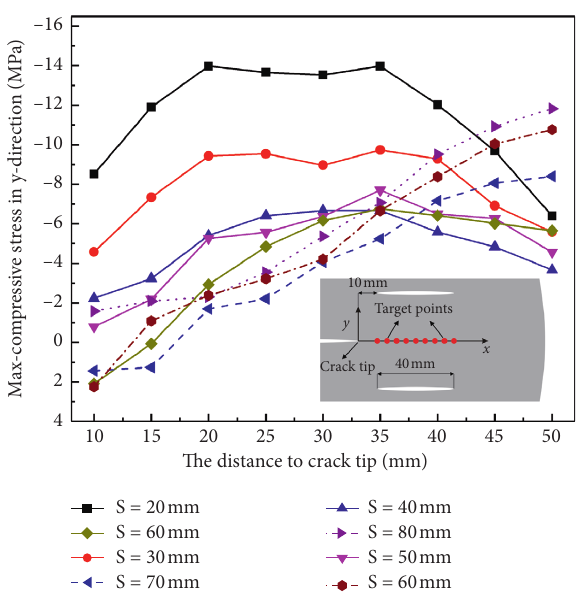
Figure 17: Maximum compressive stress in y -direction versus the distance to crack tip.